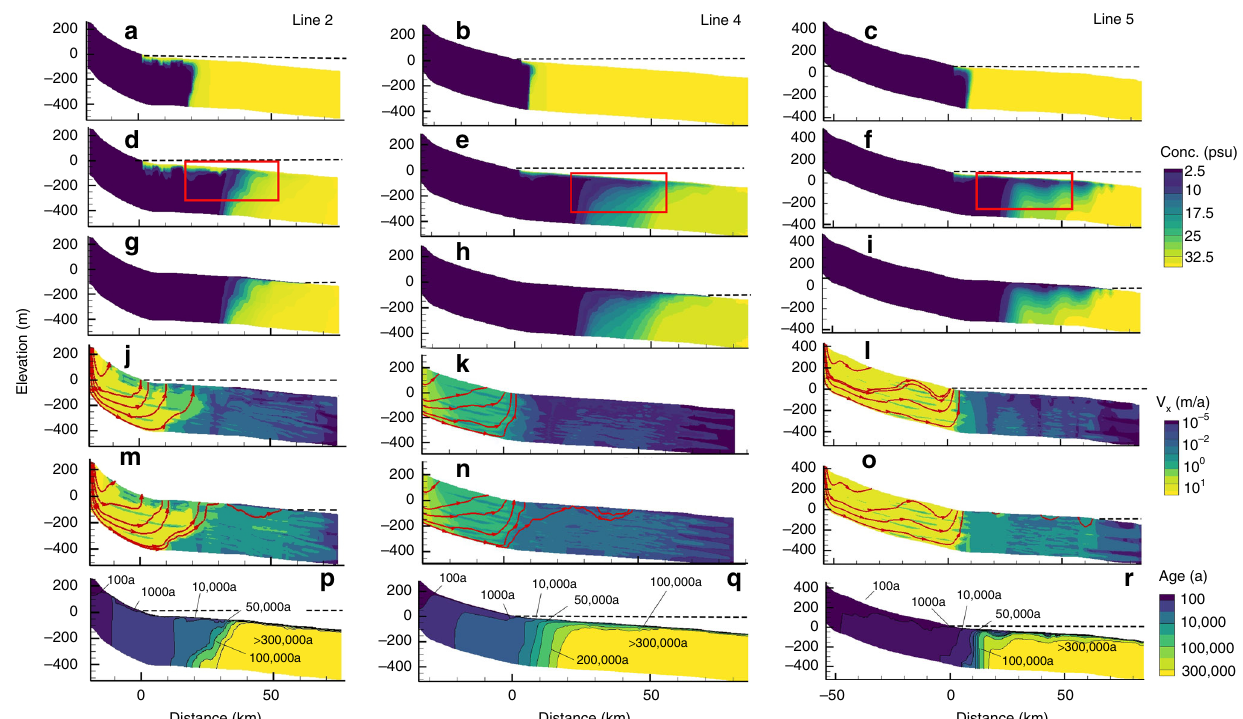
Fig. 7 Hydrological model results for lines 2, 4 and 5. a – c Computed present-day salinity after 1 Ma using fi xed, modern sea-level conditions. d – f Computed present-day salinity after 1 Ma using time-varying sea-level conditions (see Supplementary Fig. 4). The offshore section that corresponds to the CSEM pro fi les is indicated by a red rectangle. g – i Computed salinity conditions at the last glacial maximum (21 ka before present). Computed groundwater velocities ( v ) from j – l transient scenario today and m – o during the last glacial maximum. The red arrows in j – o are groundwater streamlines, which are everywhere parallel to groundwater fl ow directions. While the streamlines appear to converge to a single point near the bottom of the model domain near the coastline, distinctive fl ow tubes exist that are too thin to be distinguished. The convergence of stream tubes is due to a reduction in fl ow rates associated with the transition from a high permeability to lower permeability environments. p – r Computed present-day mean groundwater residence times from the transient simulation. Dashed line denotes sea level.